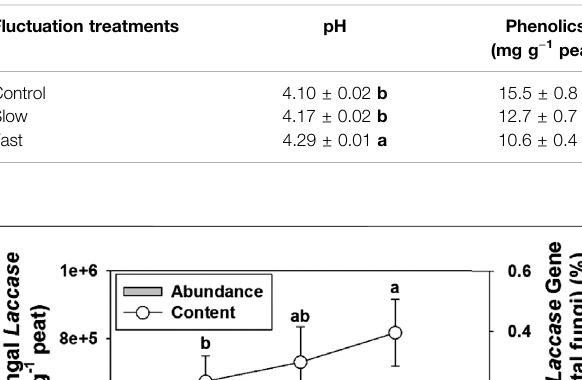
TABLE 3 | pH and concentration of phenolics in peat. Letter denotes statistically signi fi cant differences between treatments (n (cid:2) 12, 0 < 0.05).